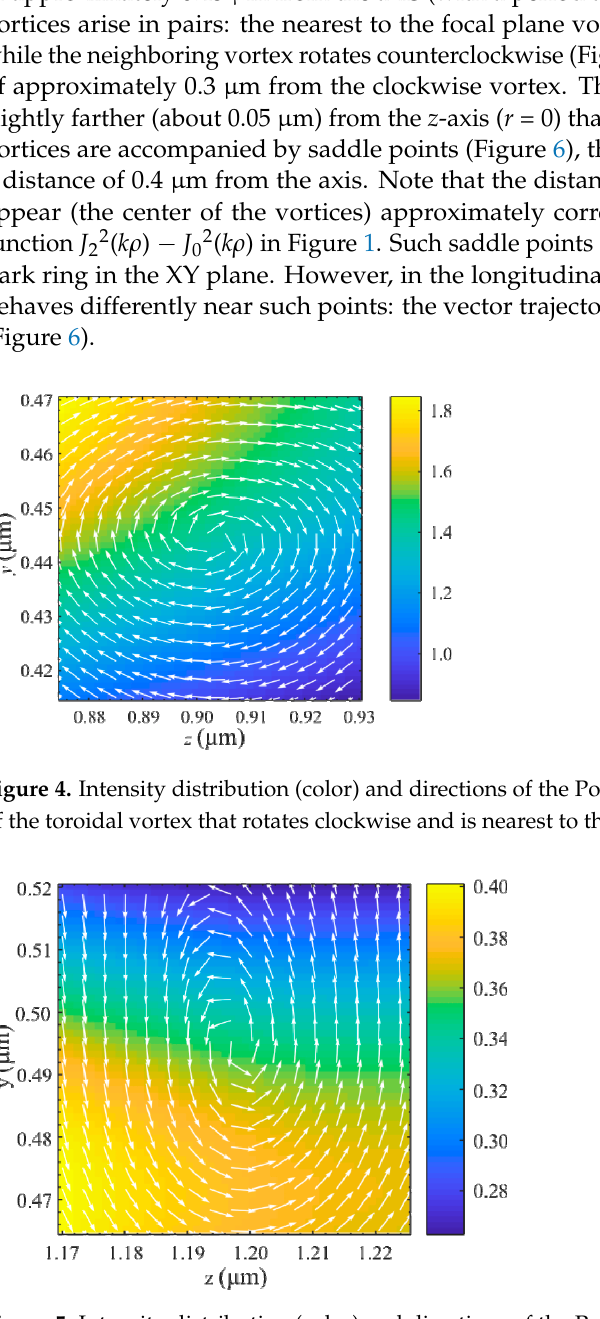
Figure 6. Intensity distribution (color) and direction of the Poynting vector (arrows) in the region of the saddle point nearest to the r - and z -axes (area 3 in Figure 3a). Figures 4–6 show the points of polarization singularity (V-points) at which the di- rection of linear polarization is undefined. The Poincaré–Hopf index is equal to η = +1